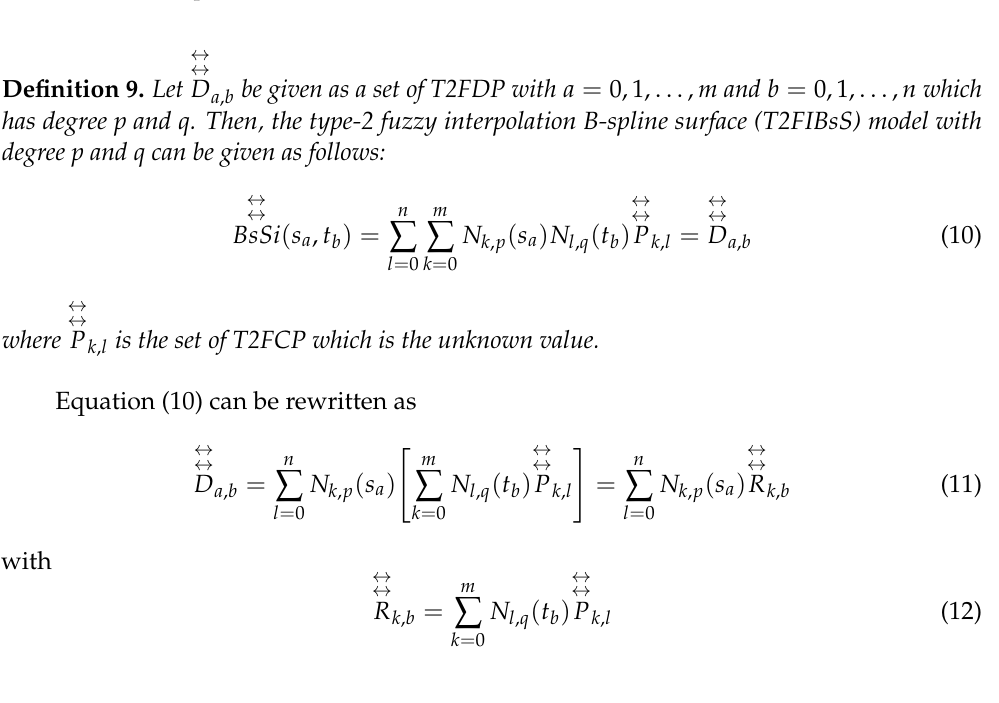
Figure 6. The example of T2FIBsC model: ( a ) with T2FCP; ( b ) without